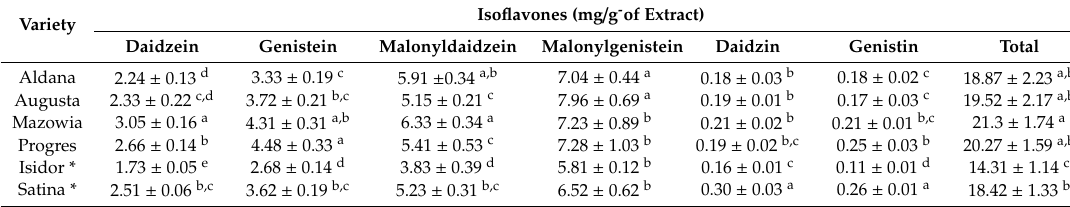
Table 3. Content of isoflavones in extracts from soybean